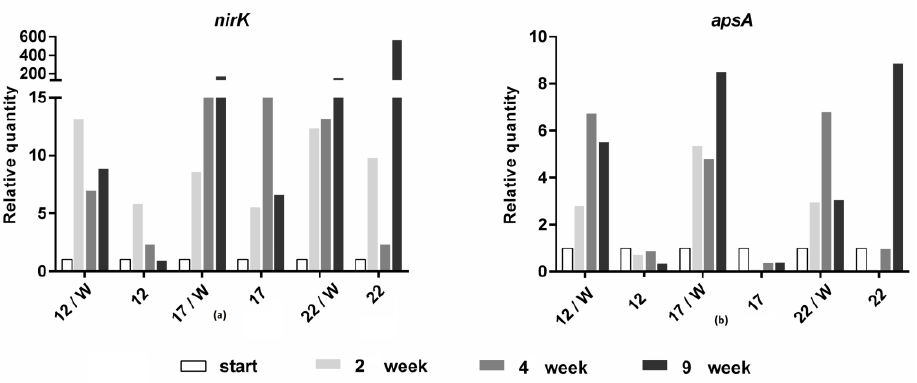
Figure 7. Changes in the quantity of ( a ) nitrate- (monitored by nirK gene) and ( b ) sulfate- (monitored by apsA gene) reducing bacteria in suspensions at different by apsA gene) reducing bacteria in suspensions at different temperatures.